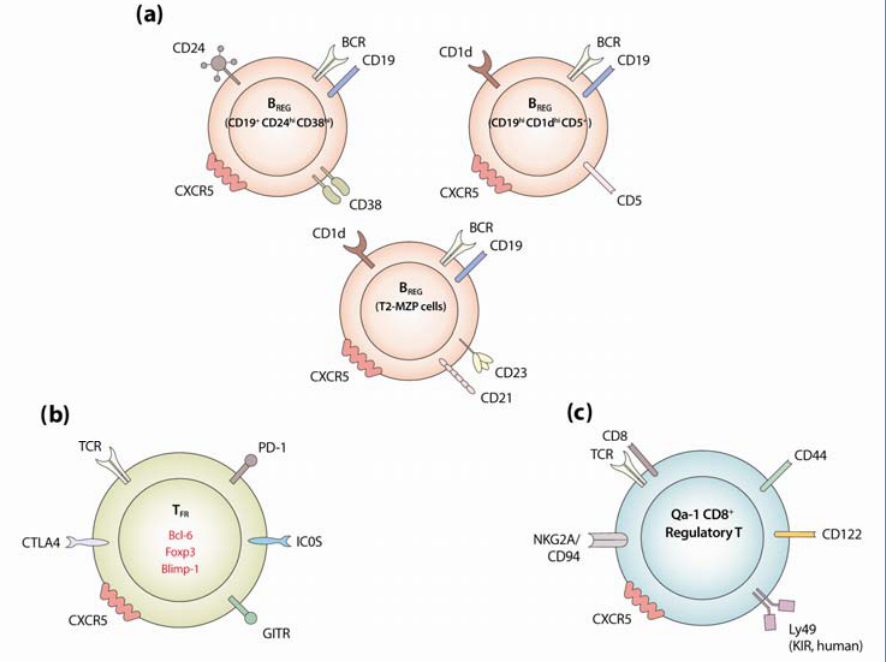
Figure 2. Diverse regulatory cells that control GC B cell responses. In order to maintain B cell tolerance to self-antigens and to control the size of GC reactions, the immune system establishes multiple subsets of regulatory cells, such as T cells, Qa-1 restricted CD8 + FR cells are known regulatory T cells, and regulatory B cells. ( a ) At least three subsets of B REG to exert immunosuppressive activity: CD1d hi CD5 + B cells, CD19 + CD24 hi CD38 hi B cells, and CD19 + CD23 + CD21 + CD1d hi T2-MZP B cells. They can be stimulated by TLR/CD40 cells express Bcl-6 and Blimp-1 in addition to Foxp3. signaling and secrete IL-10. ( b ) T FR Phenotypically, they express T -related molecules such as CXCR5, PD-1, ICOS, as well FH as the T -associated molecules CTLA4, GITR and IL-10. ( c ) T cell receptor of Qa-1 REG restricted CD8 + regulatory T cells recognize the MHC class Ib molecule, Qa-1, that is expressed exclusively on T cells. This TCR/Qa-1-peptides interaction triggers the FH suppressive activity of CD8 + regulatory T cells and limits GC reactions by inhibiting the function of T FH